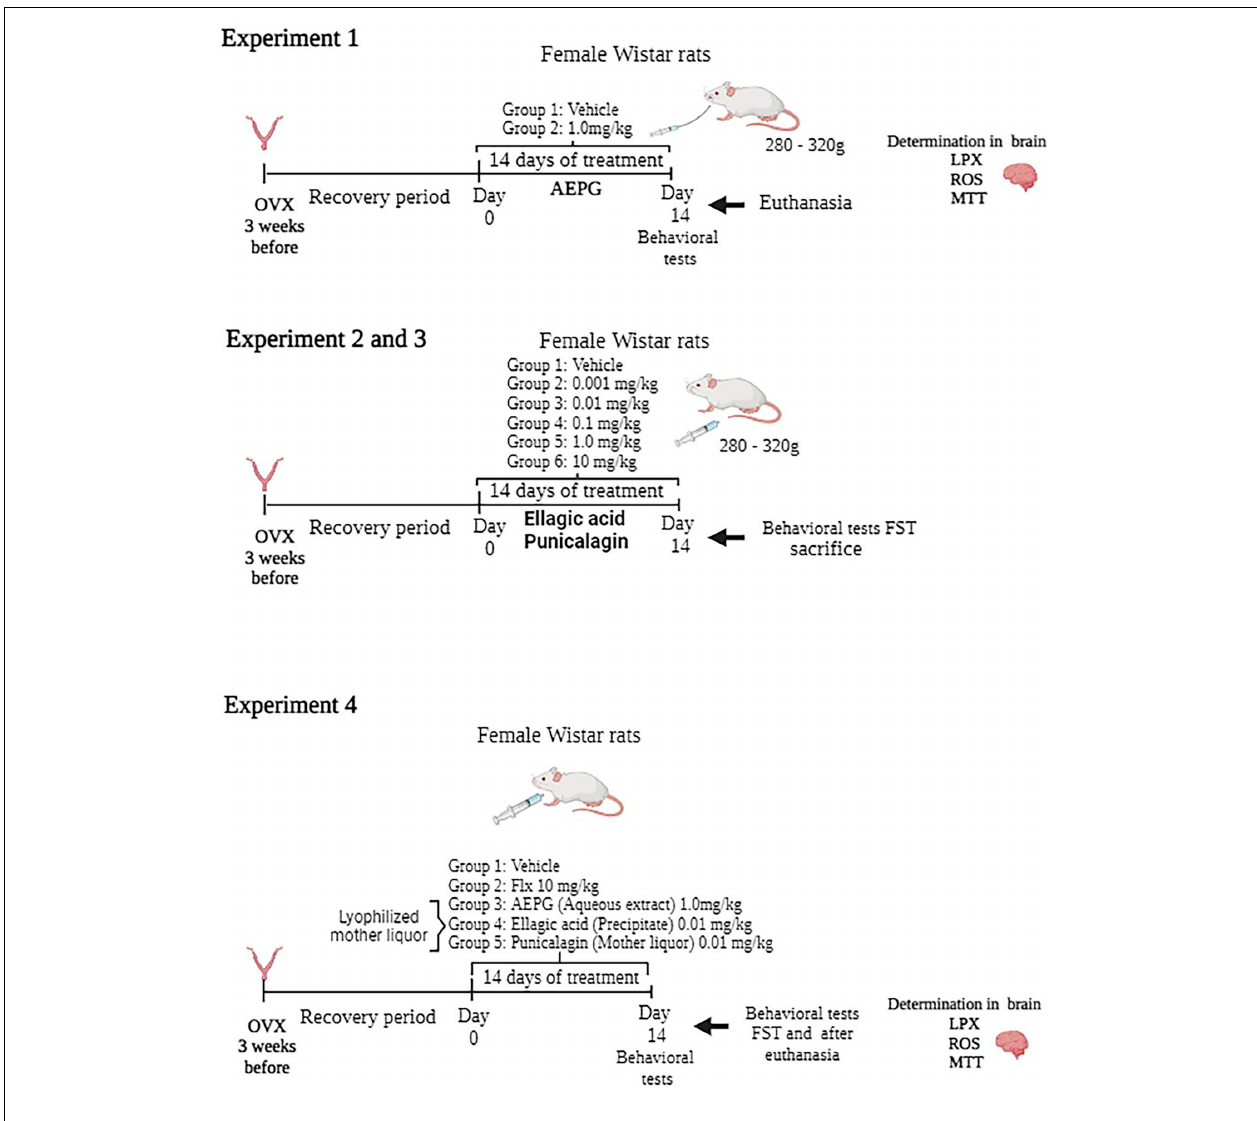
FIGURE 1 | Timeline of the experimental